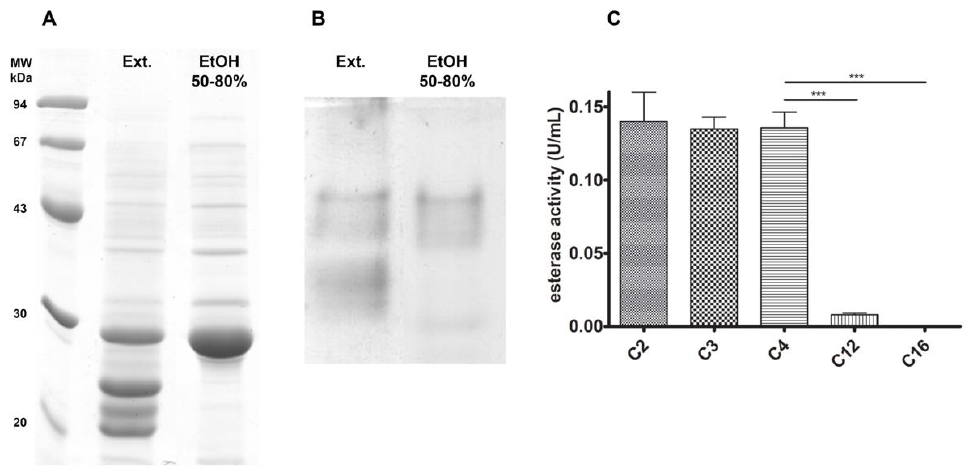
Figure 1. Esterase B enrichment with differential ethanol precipitation. After this fractionation step, the EtOH 50–80% fraction was enriched in a 30 kDa band ( A ) and a single esterase activity region ( B ). Chain specificity assay ( C ) shows that esterase B has greater activity towards short-chain esters, decreasing as chain-length increases. *** p < 0.001.